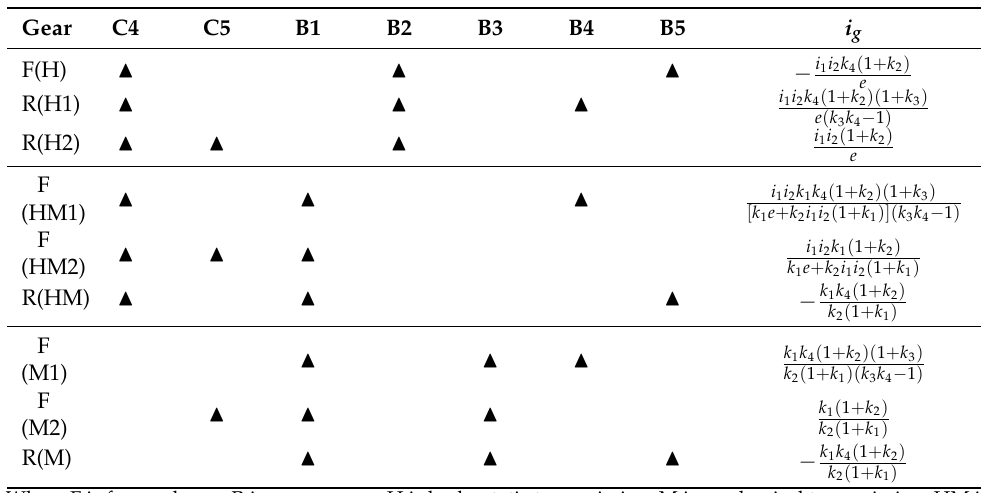
Table 2. Element engagement status and transmission ratio of each